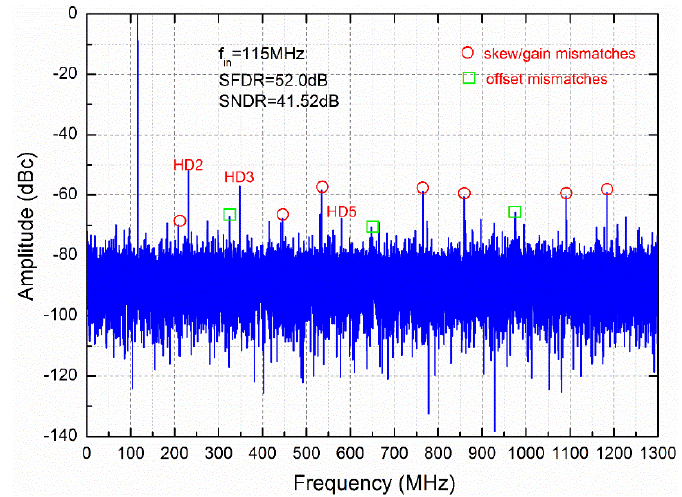
Figure 9. Output fast Fourier transform (FFT) spectrum.